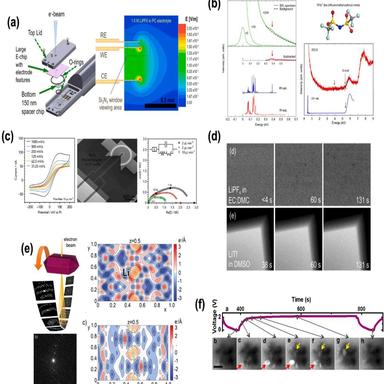
.1. Electrochemical Liquid TEM for Li-ion battery materials investigation. (a) Schematic of liquid and electrochemical TEM holder with a simulation of electric field distribution using 3 Pt straight electrodes of microchips ; (b) First example of EELS spectroscopy (high energy resolution, 7 meV) analysis, using ionic liquid drop placed on a carbon mesh grid, in low loss region corresponding to IR and UV–visible region allowing to characterise molecules, here TFSI- , inside liquid medium ; (c) SEM image of e